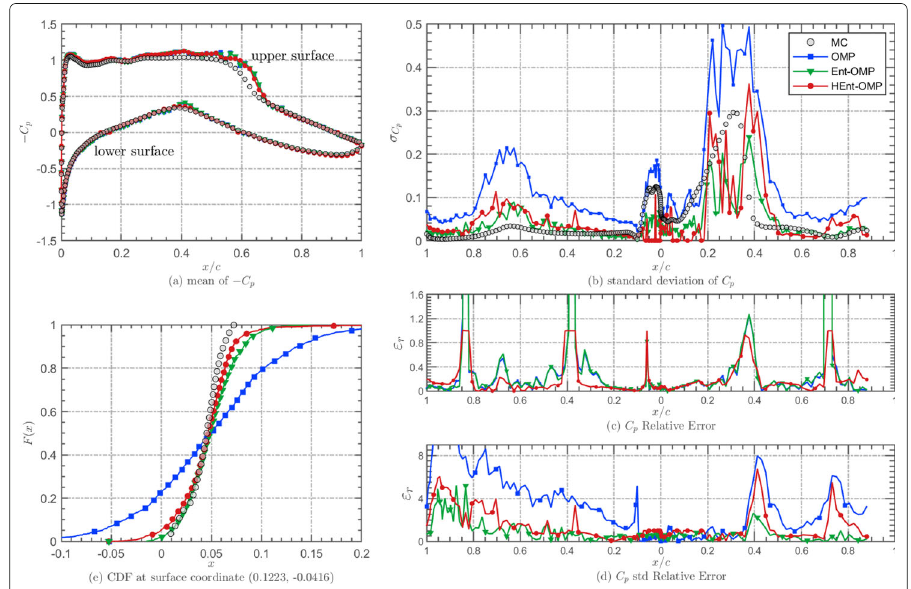
Fig. 14 Performance comparison of OMP, Ent-OMP and HEnt-OMP w.r.t. the RAE2822